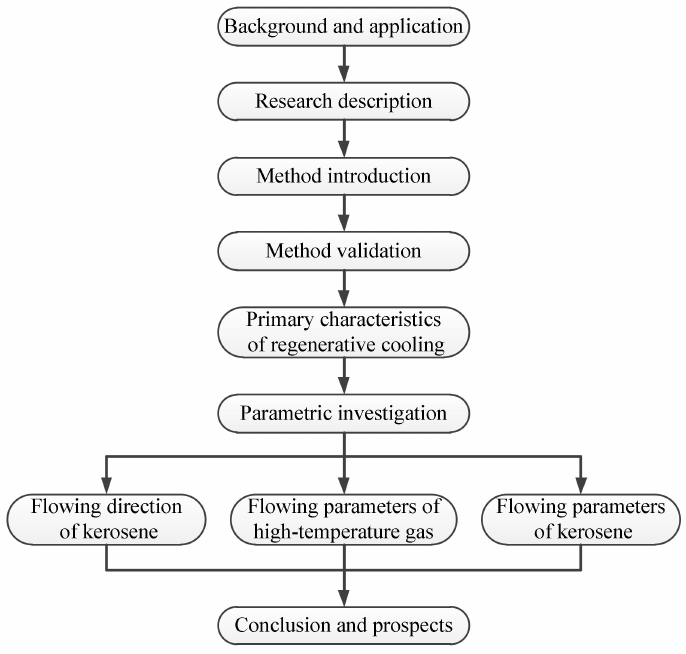
Figure 1. Block diagram of this